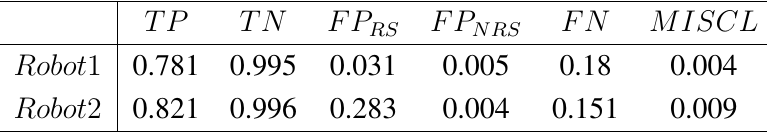
Table 3. Classification results of the detection and tracking algorithm with two robots. MISCL (misclassification rate) is the percentage of frames where the algorithm confuses one robot with the other. The rest of the acronyms have been defined in Section 6.1.